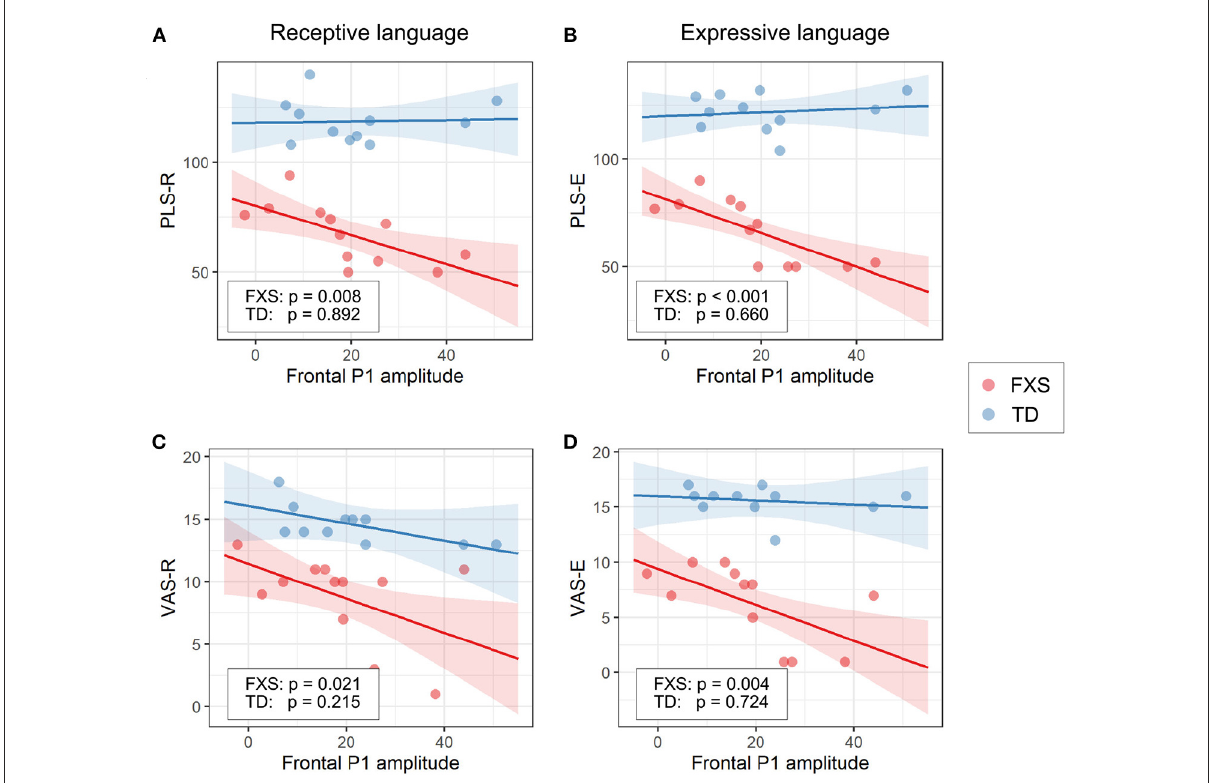
FIGURE6 Association between the frontal P1 amplitude of ST5 and (A) PLS-R, (B) PLS-E, (C) VAS-R, and (D) VAS-E in Model 1. The lines and shaded areas denote the prediction lines and their 95% confidence interval estimated by the marginal effect. The scattered dots represent individual data. The unadjusted p -value of marginal effect for each group is shown in the